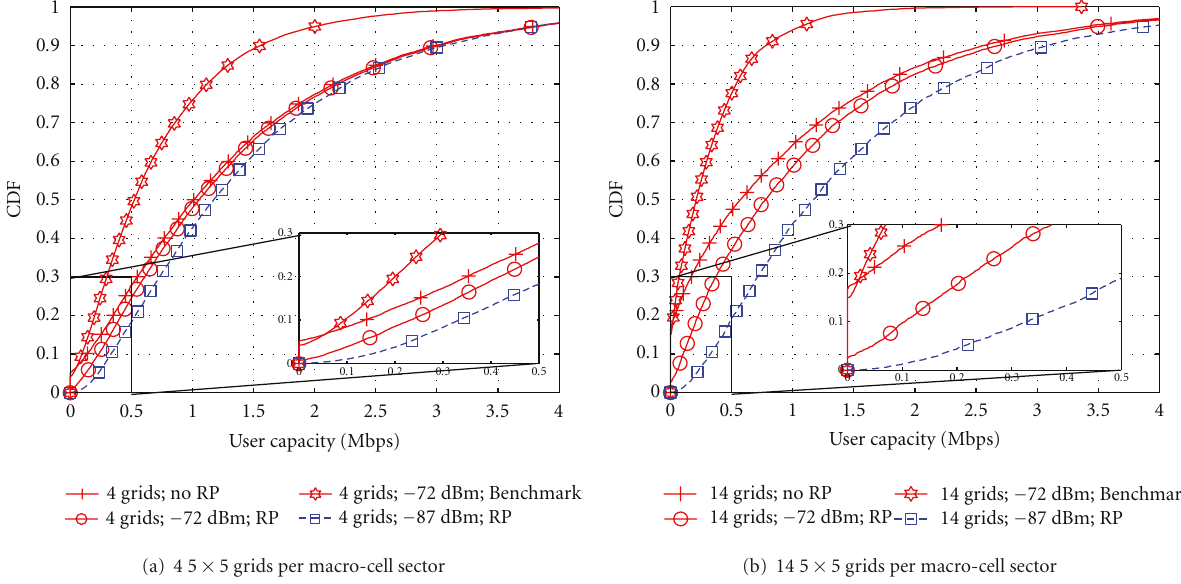
Figure 6: CDFs of the overall downlink macro user capacity for a system with and without resource partitioning, compared against the benchmark system with no femto-cell